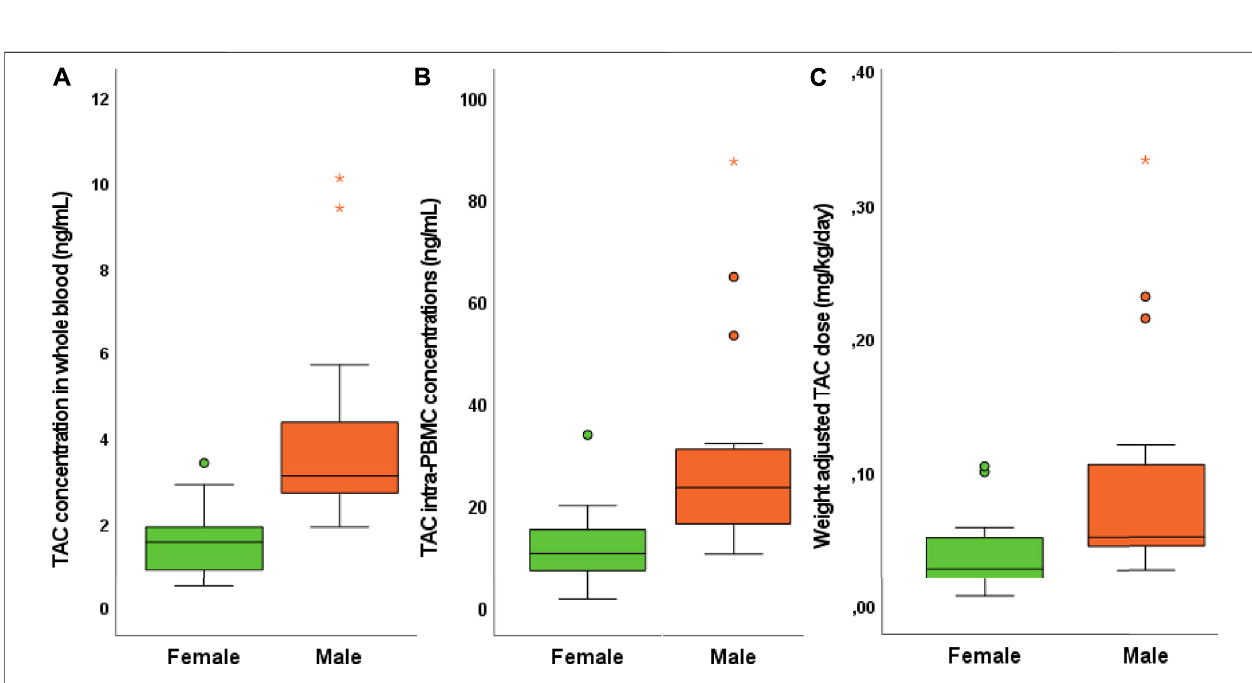
FIGURE 2 | Gender differences in TAC concentrations in WB (A) , PBMC (B) , and weight adjusted TAC dose (C) .